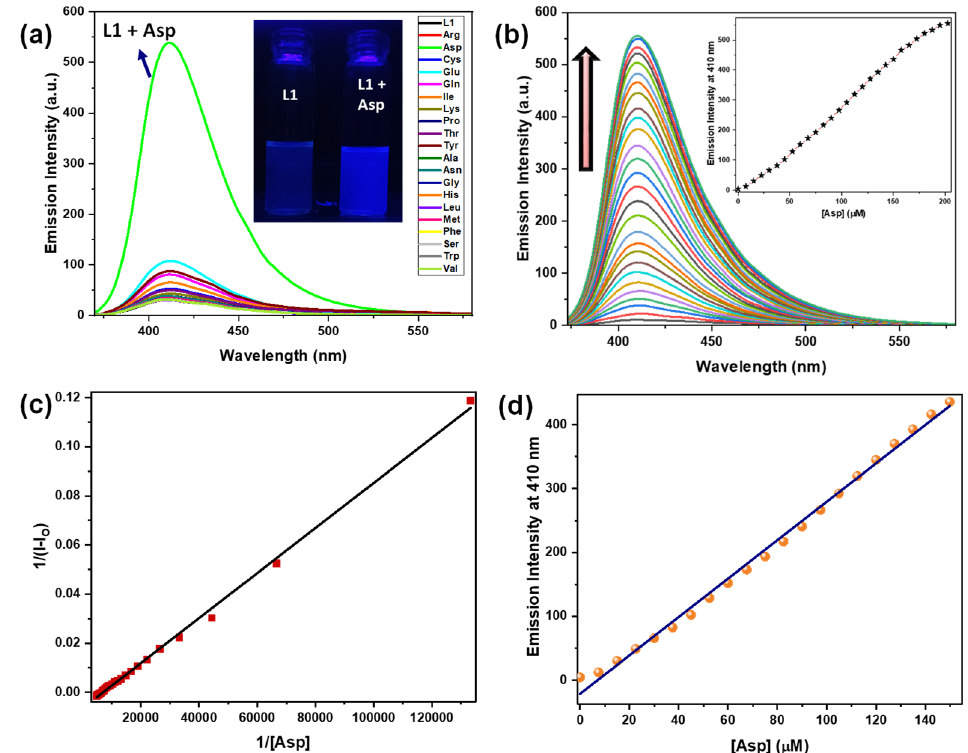
Figure 12. ( a ) Emission spectra of chemosensor L1 (c, 20 μM) in the presence of assorted amino acids. Inset displays a vial containing L1 and L1 +Asp under the UV lamp illumination. ( b ) Change in the emission spectra of L1 (c, 20 μM) on successive addition of Asp. ( c ) Determination of the binding constant by Benesi–Hildebrand plot for the detection of Asp by L1 from the emission spectral titration. ( d ) Determination of detection limit of L1 towards Asp. All studies were conducted in EtOH.